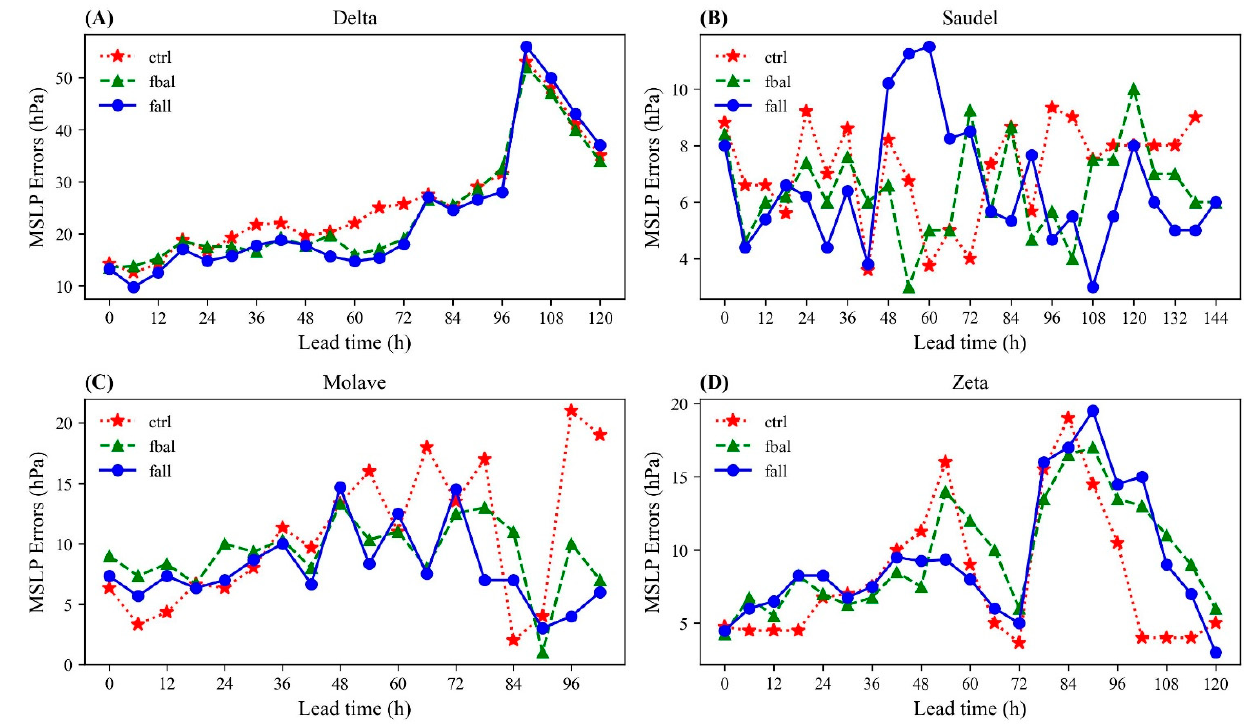
Figure 10. Intensity (MSLP) errors of Delta ( A ), Saudel ( B ), Molave ( C ), and Zeta ( D ) averaged for different initial fore ‐ cast times.